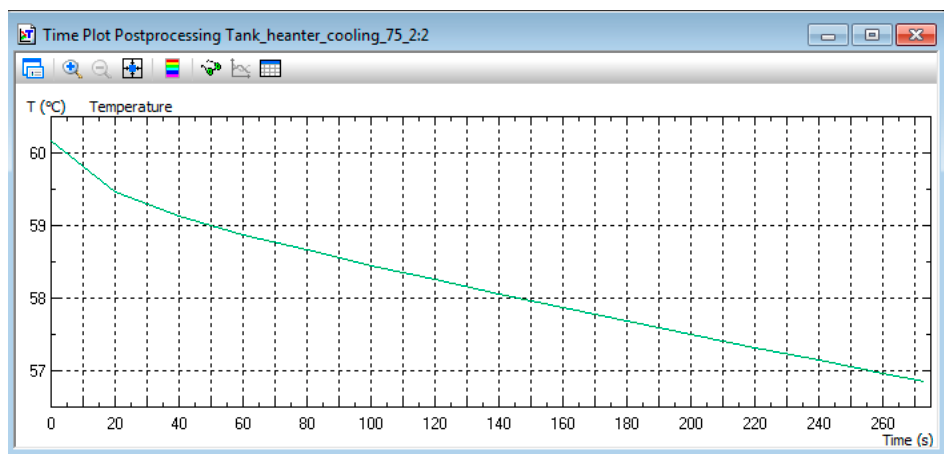
Figure 15. The temperature changes of the AMD ferrite ring during the cooling process for 273 s. The final average cooling of volume temperature of the AMD ferrite ring was 56.83 ◦ C. If we substituted this value into the regression equation of the AMD cooling (Table 5), we would obtain a value of approximately 61 s. It is possible to solve this problem if the integration time in the second cooling problem is set to 335 s. Figure 16 demonstrates the results of the simulation.